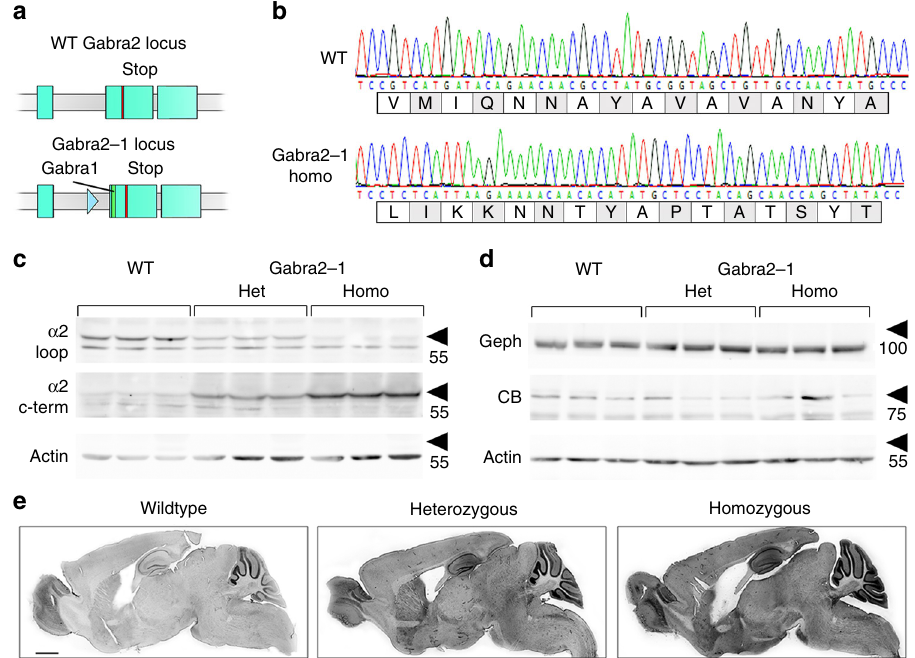
Fig. 3 Generation and basic characterization of α 2 – 1 knock-in ( Gabra2 – 1) mice. a Cartoon showing the targeting vector used to insert residues 358 – 375 from the α 1 subunit into exon 10 of the α 2 subunit, and the resulting allele. b Sequencing of PCR ampli fi ed genomic DNA from wildtype and Gabra2 – 1 homozygous mice, and predicted amino acid sequence. c Hippocampal extracts from wildtype and Gabra2 -1 heterozygous and homozygous mice were immunoblotted with antibodies directed at the large intracellular loop (loop) and the c-terminus (c-term) of the GABA A R α 2 subunit. d Immunoblotting with antibodies for gephyrin (Geph) and collybistin (CB) in wildtype and Gabra2 -1 mice. See Supplementary Fig. 2 for uncropped blots and quanti fi cation of immunoblotting. e The 40 μ m saggital sections immunostained with α 2 c-term antibody and HRP-conjugated secondary antibody, and visualized using 3, 3 ′ -diaminobenzidine staining. Scale bar = 1500 µ m. See Supplementary Fig. 3 for quanti fi cation of α 2